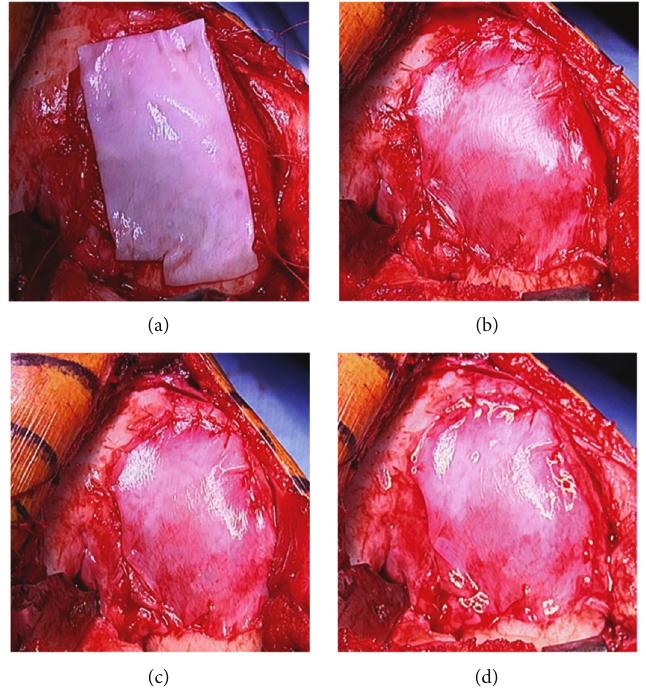
Figure 10: Second MACI stabilization. (a) MACI graft # 2 cell layer down. (b) MACI graft # 2 suture stabilization. (c) MACI graft # 2 sewn. (d) MACI grafts sewn with fi brin